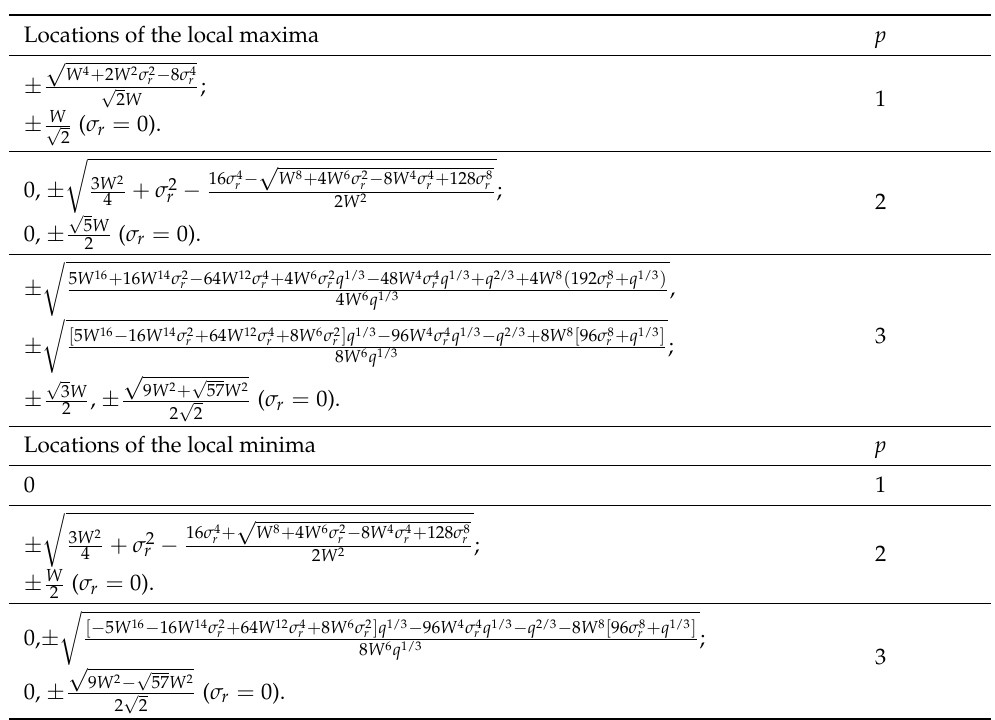
Locations of the local